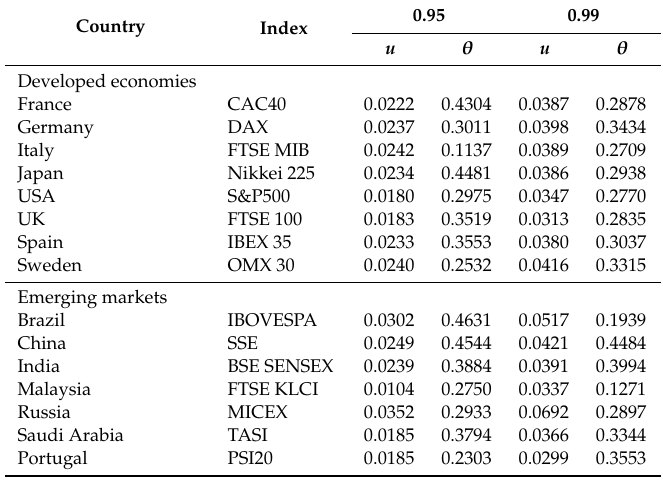
Figure 3. Daily log returns of ( a ) IBEX 35, ( c ) FTSE MIB, ( e ) SSE for the period from 1 July 1997 to 16 January 2017, that consists of an average of ( n = 5000) observations. The estimated extremal index of ( b ) IBEX 35, ( d ) FTSE MIB, ( f ) SSE at a range of threshold u . Table 2. The estimated extremal index θ for developed and emerging